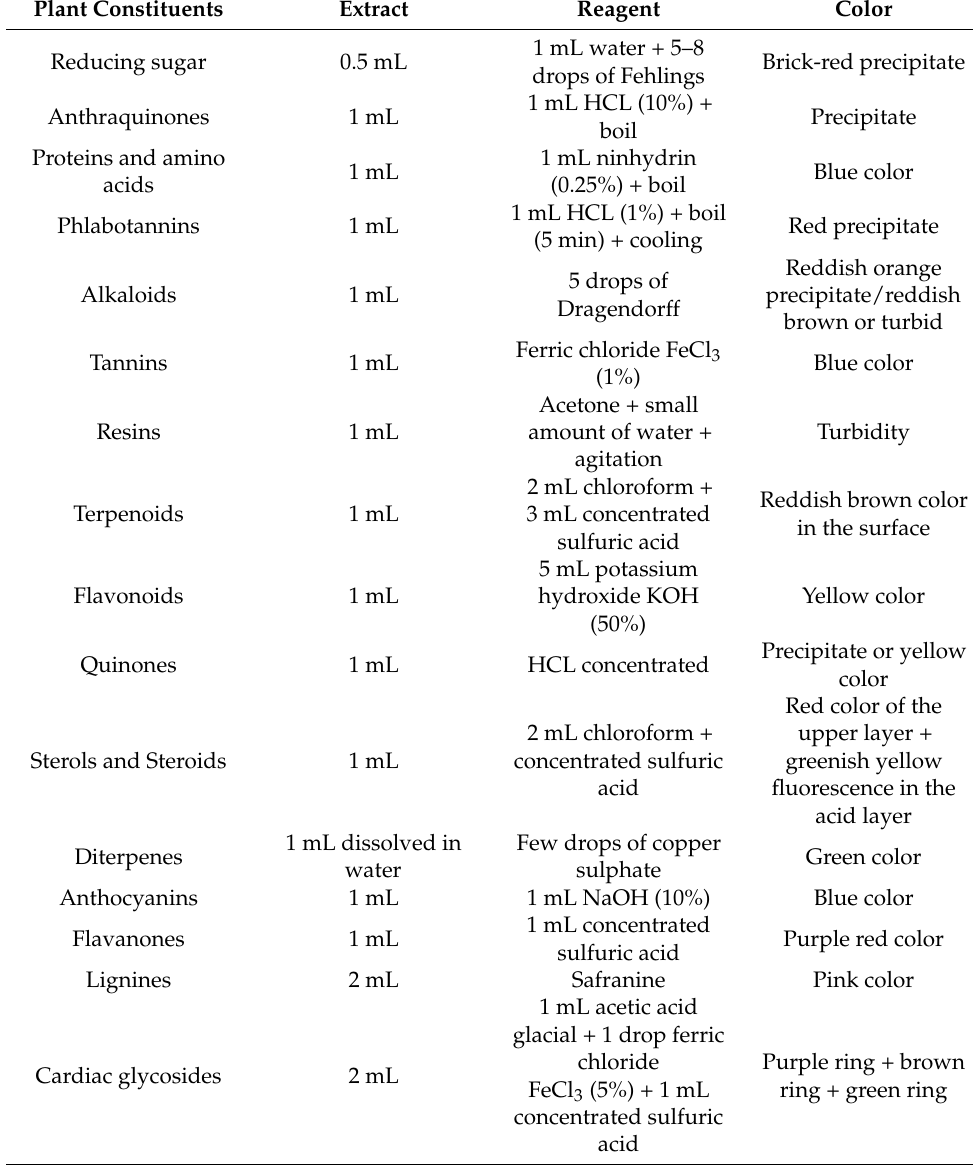
Table 4. Phytochemical screening